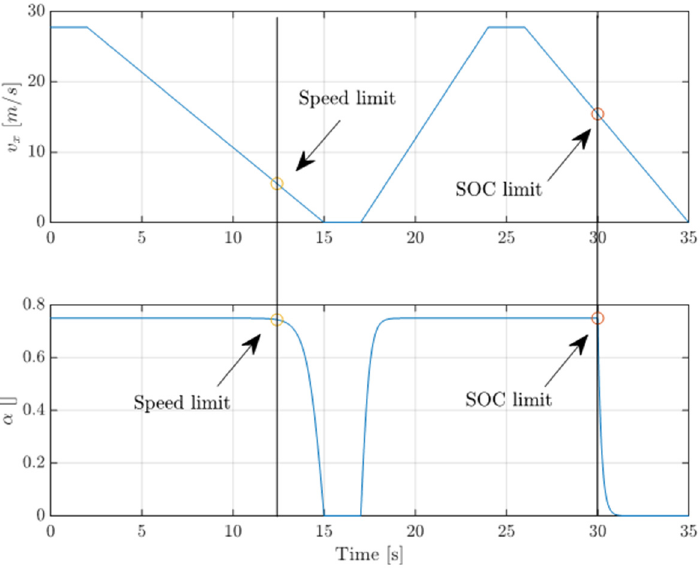
Figure A2. Illustration of the ( a ) parallel and ( b ) series blending strategies.